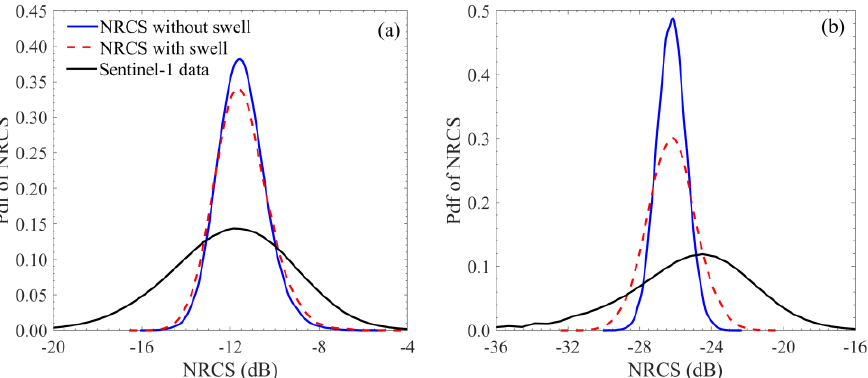
Figure 15. Two examples of scattering pdfs predicted by the modified TSM from Tayfun sea surface without and with swell and their comparison with the Sentinel-1 data. ( a ) Incidence angle is 35°, wind speed is 13 m/s, wind direction is 240° relative to range direction, VV polarization, significant wave height of swell is 4 m, swell wavelength is 200 m, and direction of the dominant wave is 180° relative to range direction; ( b ) incidence angle is 44°, wind speed is 7.4 m/s, wind direction is 91° relative to range direction, HH polarization, significant wave height of swell is 4 m, swell wavelength is 196 m, and direction of the dominant wave is 191° relative to range direction.